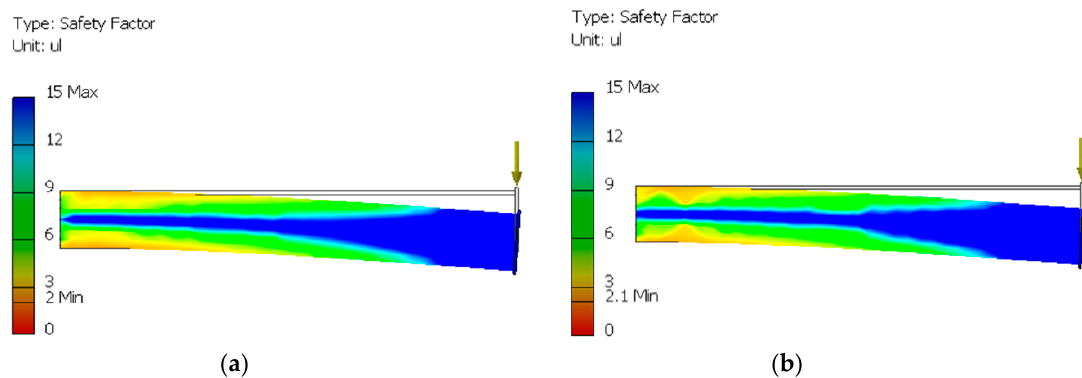
Figure 3. Safety factor (SF) appraisal apropos the flexibility analysis of specimens 2 of ( a ) PE 80 and ( b ) PE 100 as enlisted in Table 2.